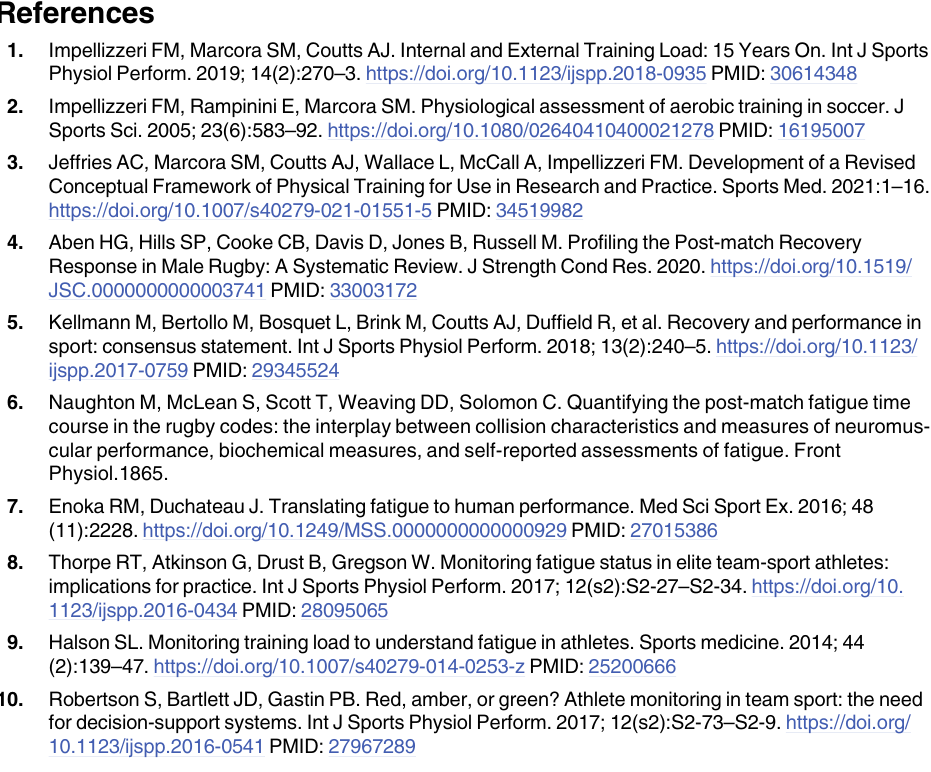
S1 Table. Characteristics of items which did not achieve consensus ( � 67% agreement) across two adjacent categories in the two round Delphi study including the largest consen- sus agreement obtained, the median rating, and the round in which agreement and rating was